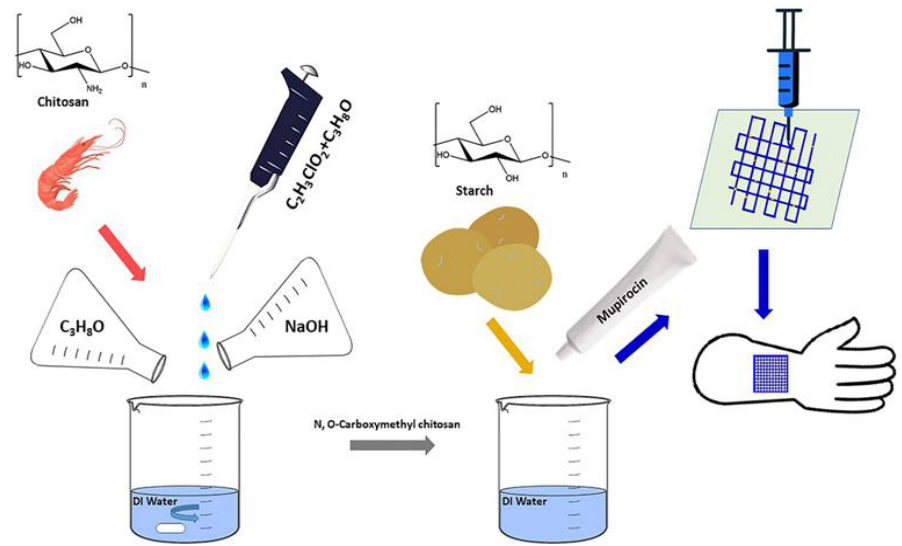
Figure 22. Three-dimensional printing of starch NOCC wound dressing scaffolds.